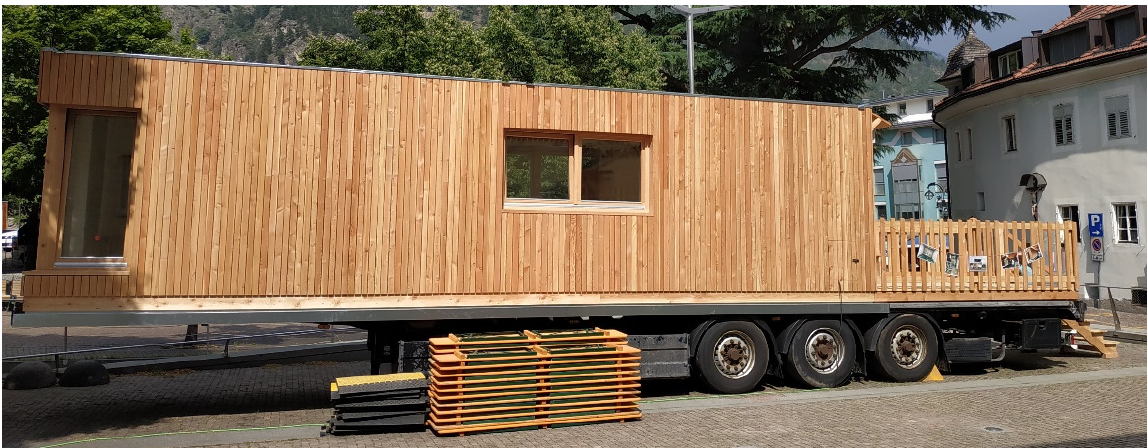
Figure 2. The Tiny FOP MOB prototype (exterior view).